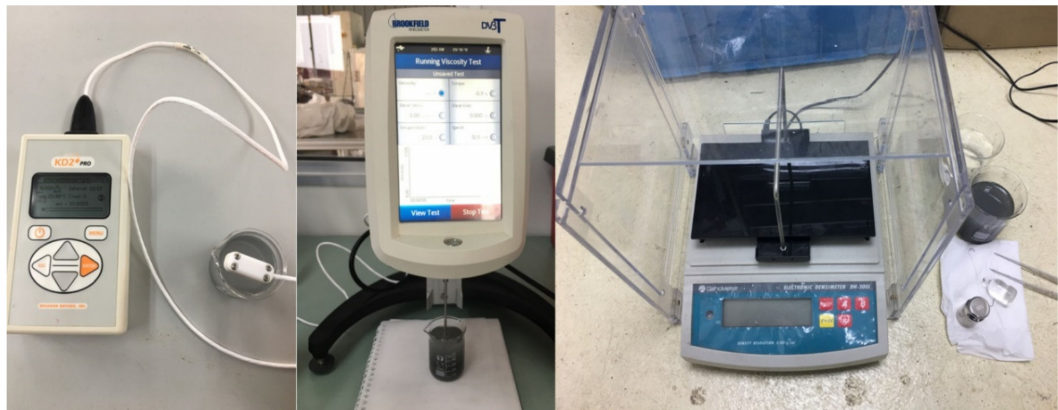
Figure 7. Equipment for thermal physical characterization.